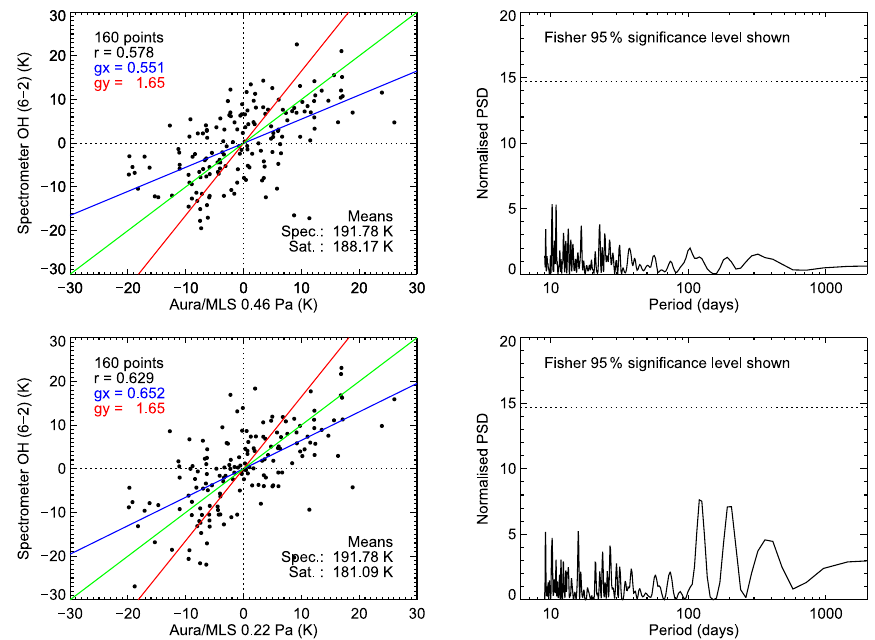
Figure 5. Examples of the comparison between the spectrometer OH temperatures and the Aura MLS temperatures. The panels on the left show the correlation values between the spectrometer and Aura MLS temperatures for the 0.46Pa (top) and the 0.22Pa (bottom) retrieval levels. The blue and red lines indicate lines of best fit made assuming all experimental errors are in the Aura MLS and the spectrometer, respectively. The green line indicates the y = x line. The right-hand panels indicate Lomb–Scargle periodograms for the residuals between the spectrometer and Aura MLS temperatures corresponding to the left-hand